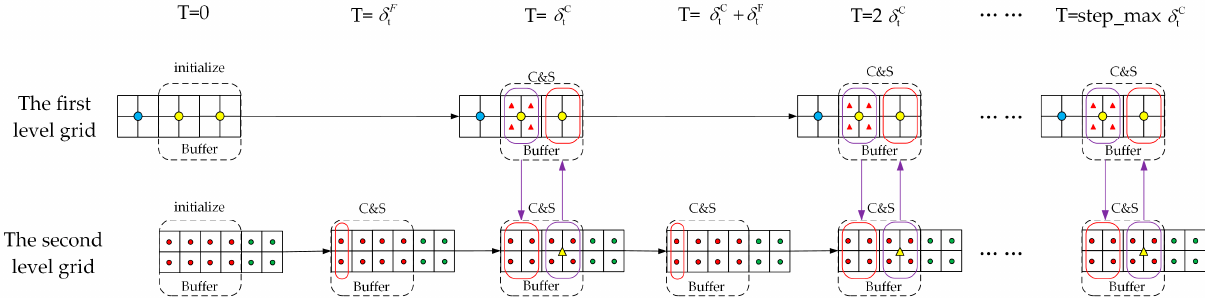
Figure 13. Schematic diagram of MRT-LBM calculation of two-level grid.